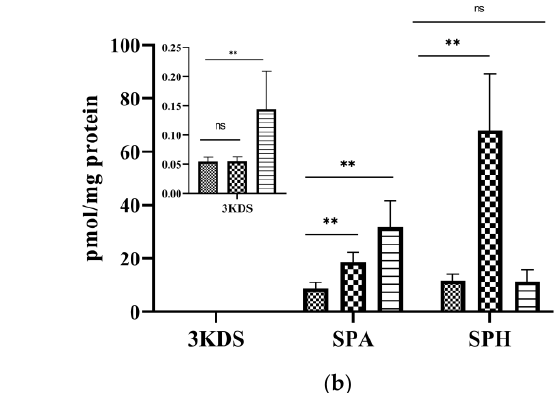
( b ) Figure 3. ( a ) Deutralized KDS and SPA accumulation by PF-543 and DPF-543; ( b ) PF-543 and DPF-543 impact on en- dogenous sphingoid bases. Data are shown as means ± SD, ns—not significant, ** p < 0.01.